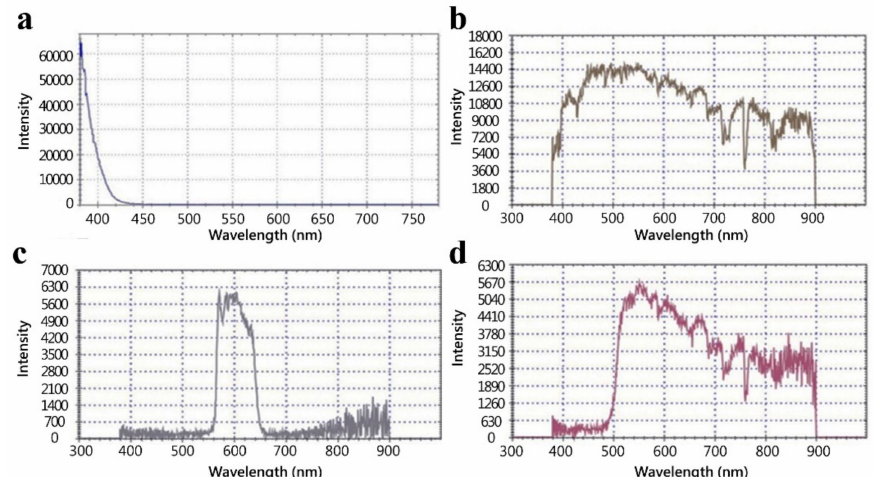
Figure 3. Wavelength measurement of the UV-LED and light filters. ( a ) UV-LEDs emit light with a peak intensity below 400 nm. ( b ) Sunlight was used as a light source with full wavelength. ( c and d ) The wavelength of sunlight penetrating through a band-pass 600 nm filter and a long-pass 500 nm filter,